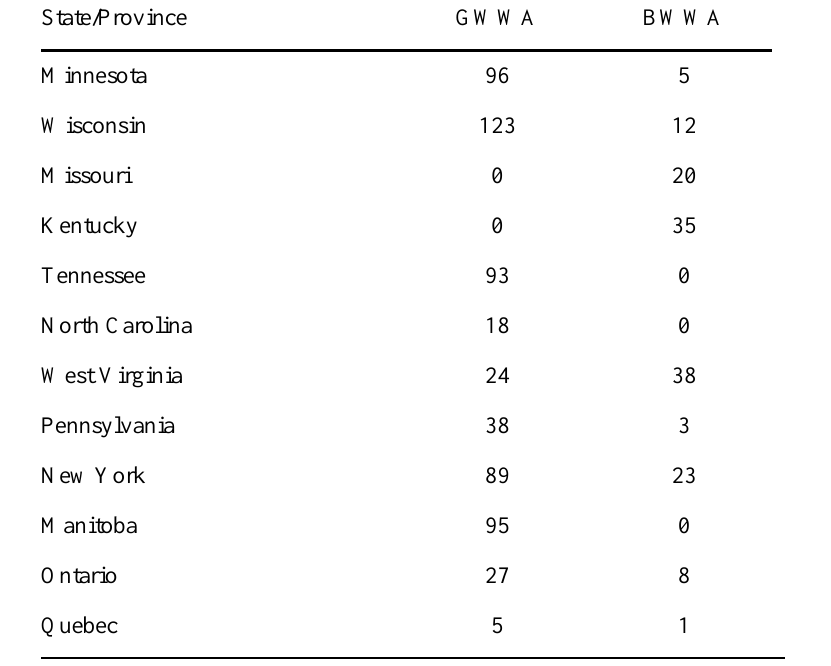
Table 1 . Number of Golden-winged (GWWA) and Blue-winged Warbler (BWWA) samples collected in each state/province.